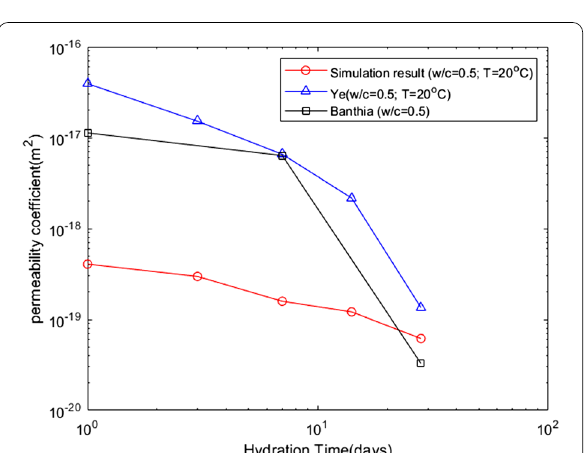
Fig. 9 Comparison of permeability vs. w/c ratio with experimental result.